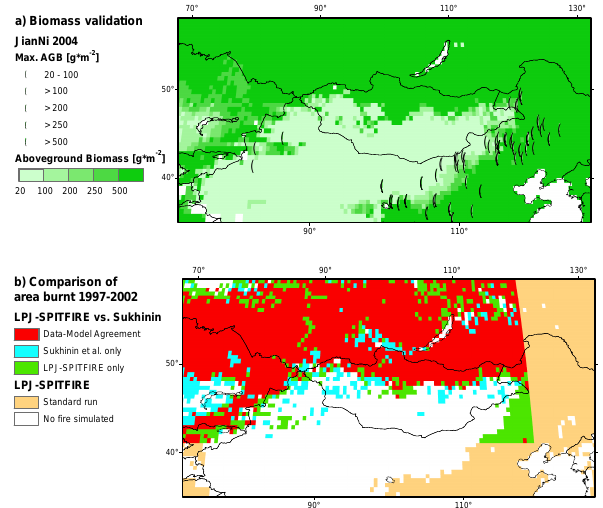
Fig. 8. (a) Comparison of observed (Ni, 2004) and simulated net primary production in northern China. (b) Comparison of observed (Sukhinin et al., 2004) and simulated area burnt for 1997–2002, fol- lowing the conventions of Fig. 7.